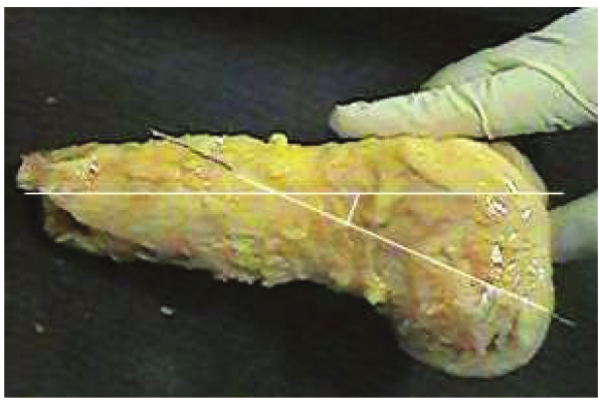
Figure 2 – Femoral sagital cut. Thickness of the posterior